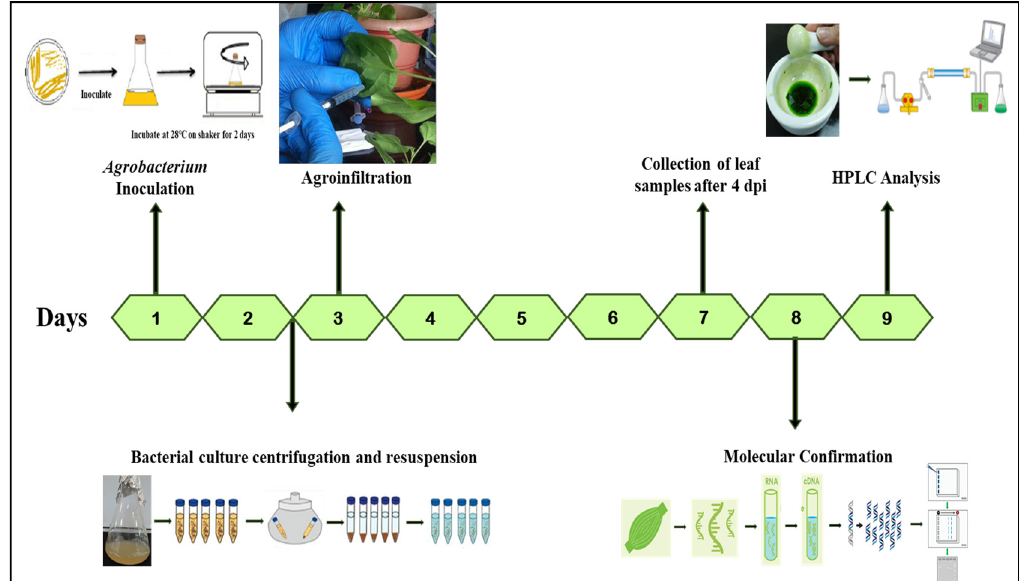
Figure 2. Timeline and diagrammatic representation showing the production of secondary metabolites in plants by tran- sient gene expression.